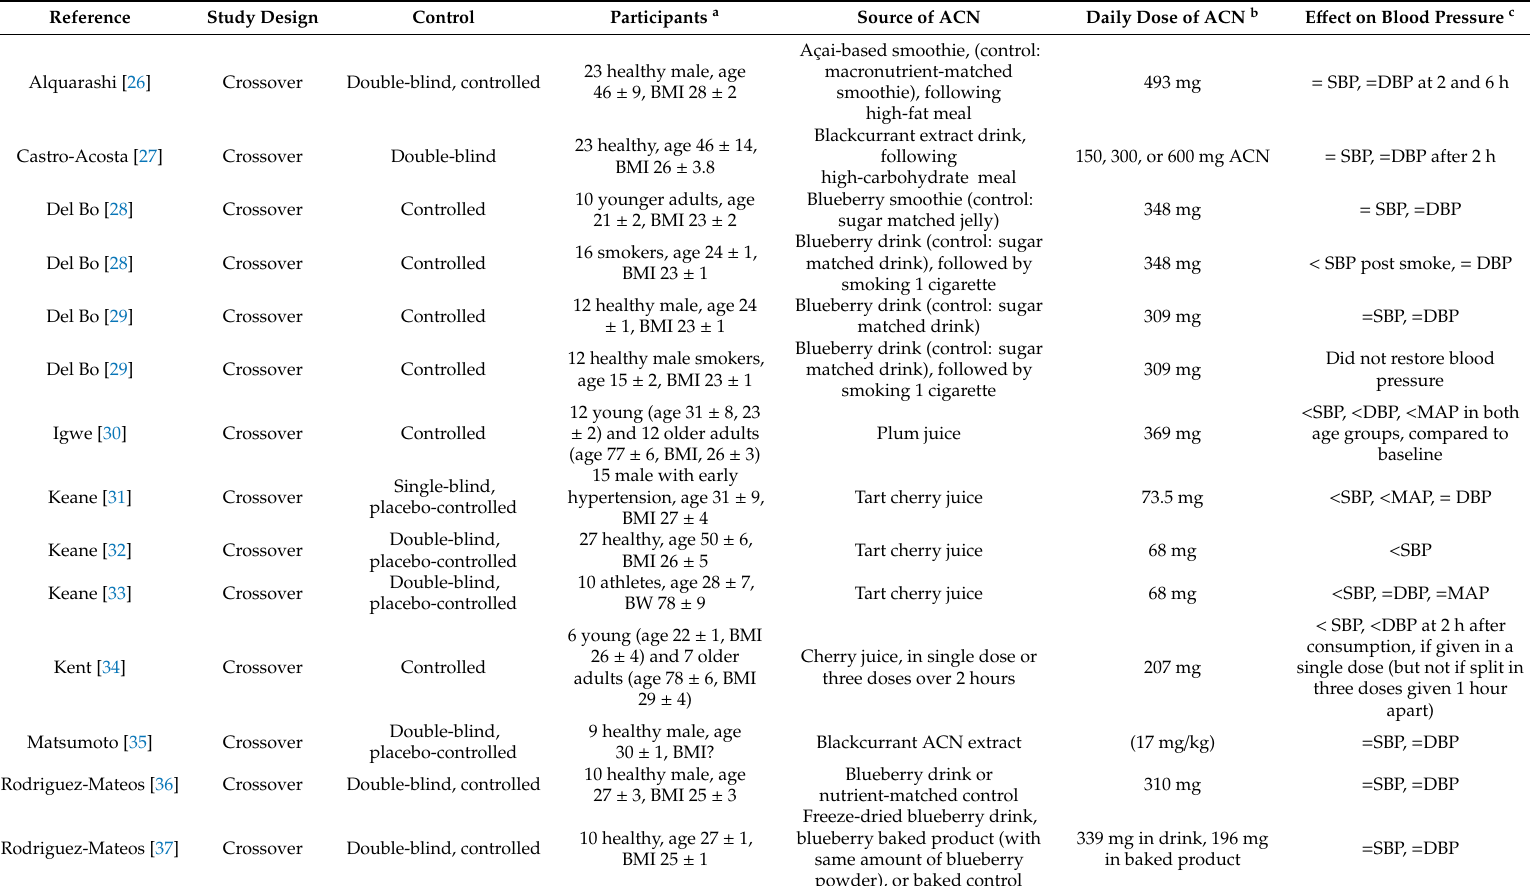
Table 1. Summary of single dose